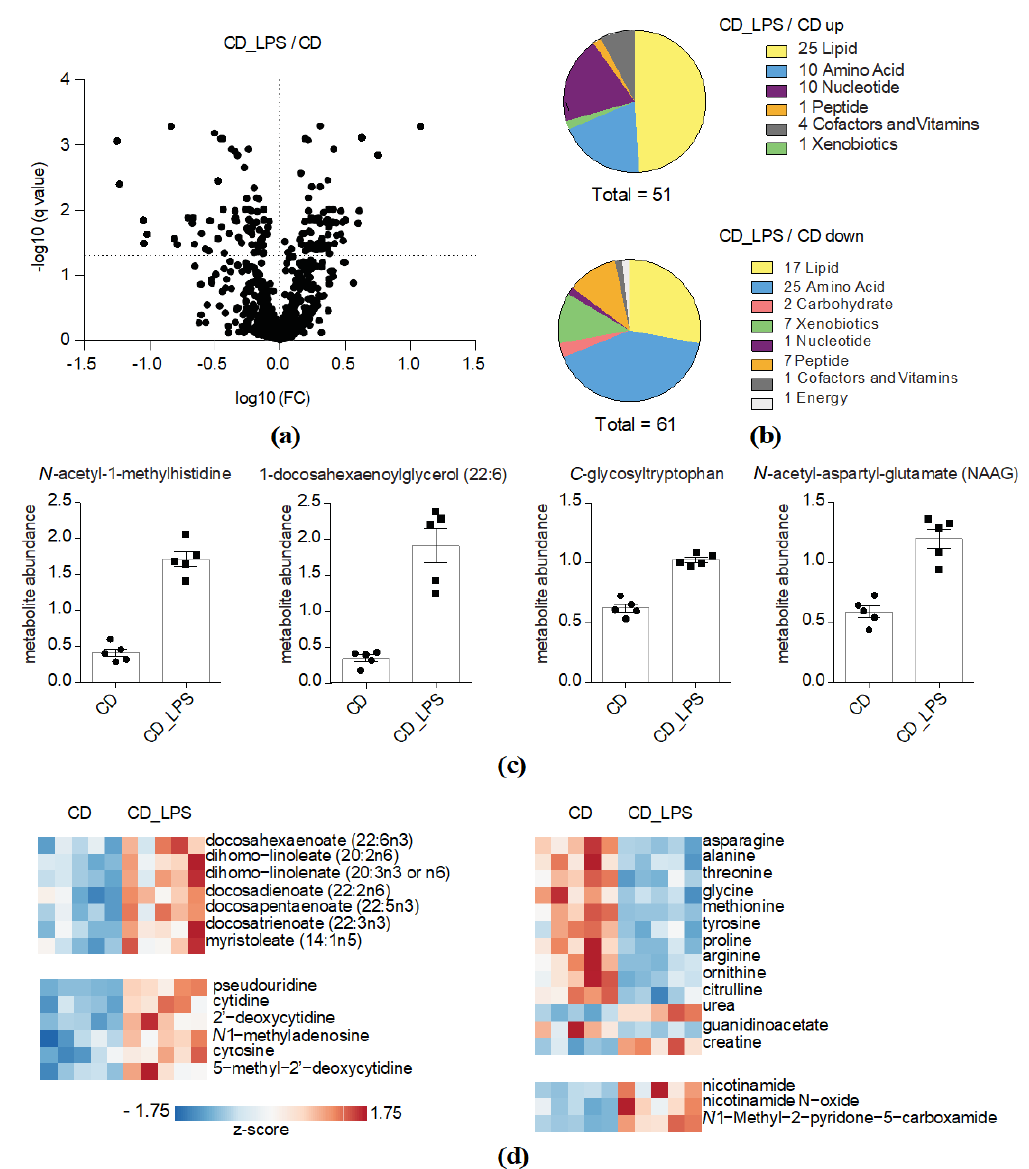
Figure 2. LPS challenge specifically increases systemic protein and amino acid catabolism. ( a ) Volcano plot indicating changes in metabolite abundances between the CD_LPS-treated and the CD-fed group ( q value < 0.05 is considered significant). − log10 and log10 q -values and fold changes, respectively, are depicted; ( b ) Pie charts indicating numbers of altered metabolites in the CD_LPS-treated group compared to the CD-fed group based on their biological classification; ( c ) Abundances of significantly up- or downregulated metabolites in the CD_LPS-treated group. Individual values, means and SEM are presented; ( d ) Representation of significantly up- or downregulated metabolites in the CD_LPS group. Metabolite abundances were z -transformed and scaled.